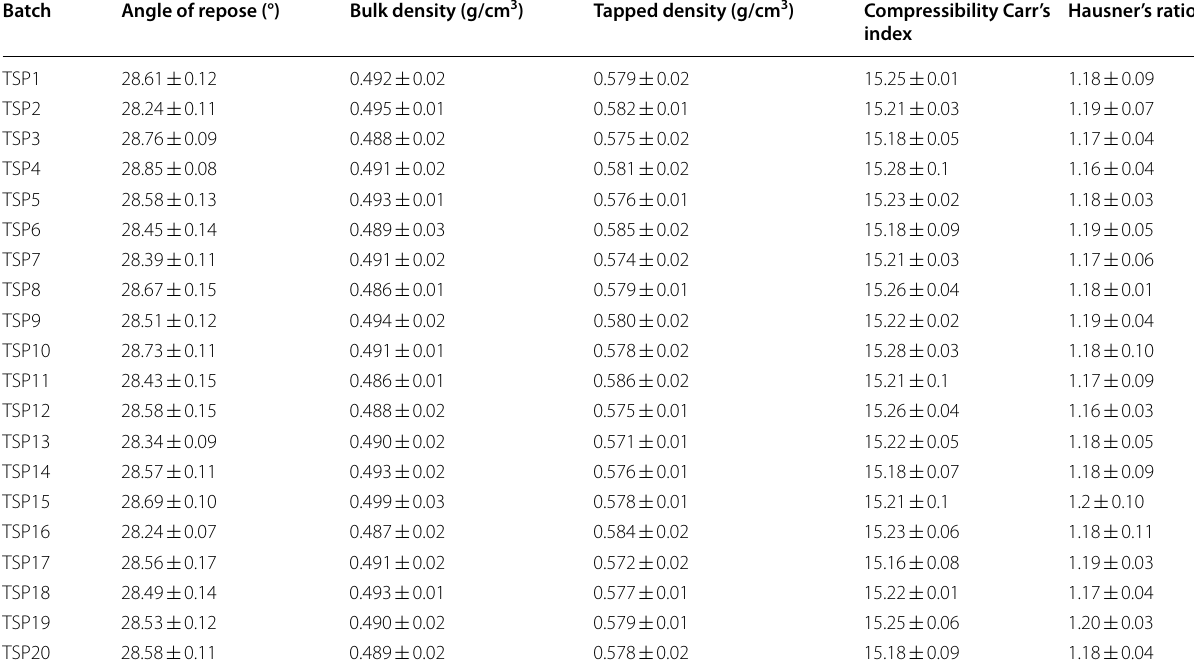
Values are expressed as mean